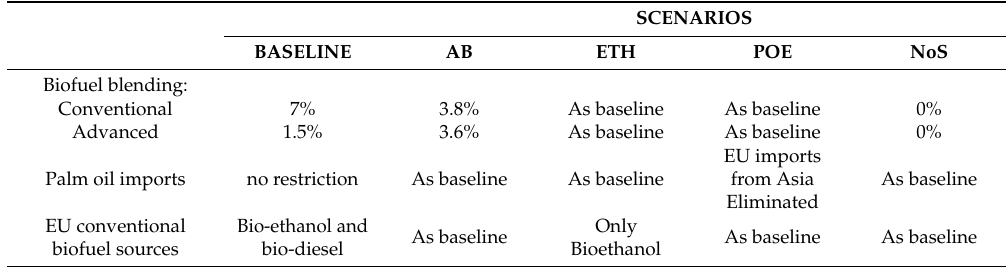
Table 4. Scenario overview, changes compared to baseline (period